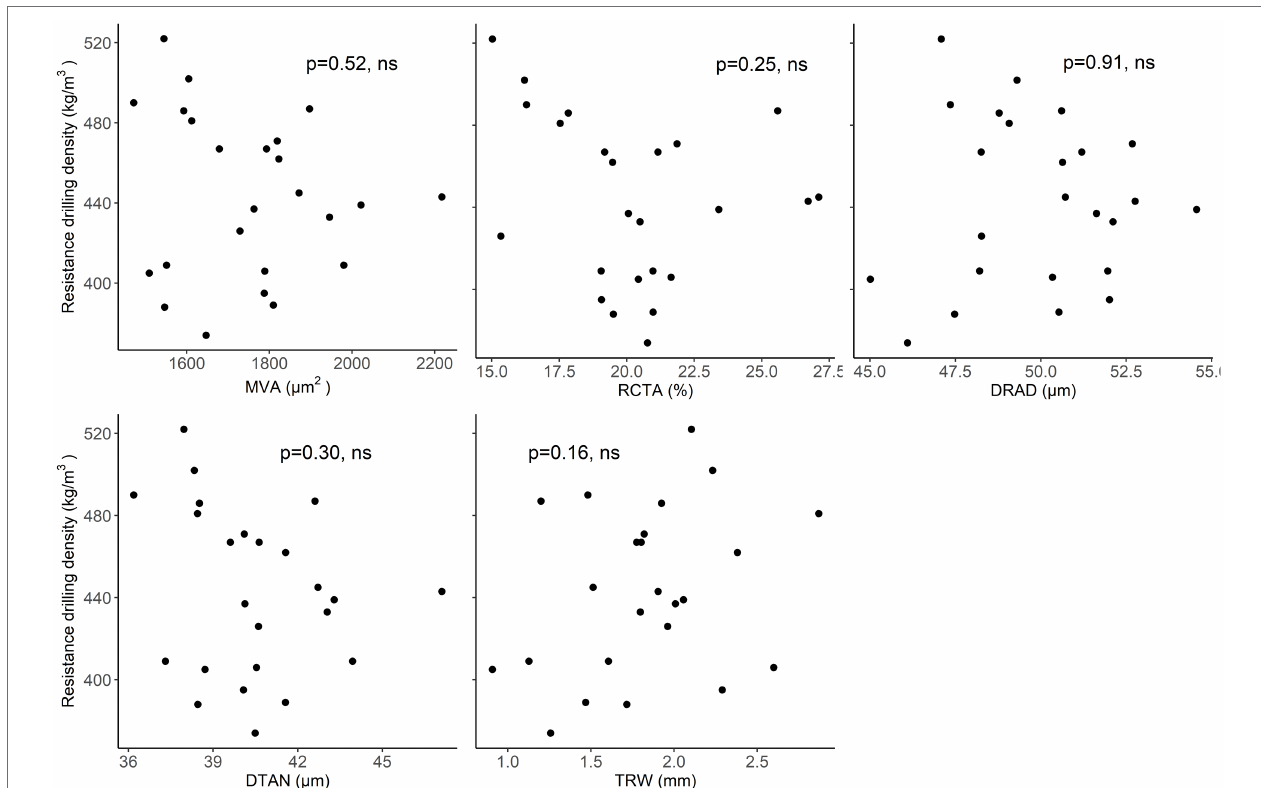
FIGURE 8 | Relationships between mean resistograph values and wood-anatomical features (MLA—mean lumen area, RCTA—relative conducting area, DRAD— radial lumen diameter, DTAN—tangential lumen diameter, and TRW—tree-ring width) in